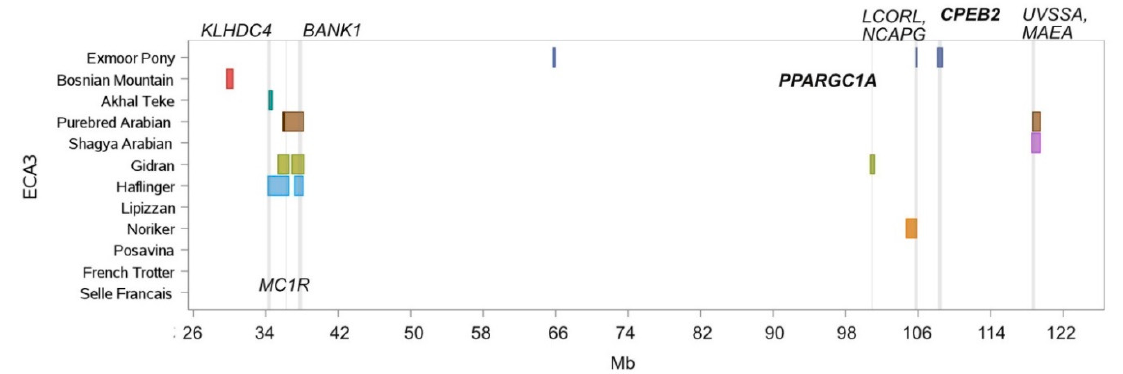
Figure 4. ROH islands on ECA3 between 26 Mb and 122 Mb. Location and length of ROH islands (shared by more than 50% of individuals per breed) per breed are illustrated as horizontal boxes, location of genes of specific interest are indicated as vertical lines.